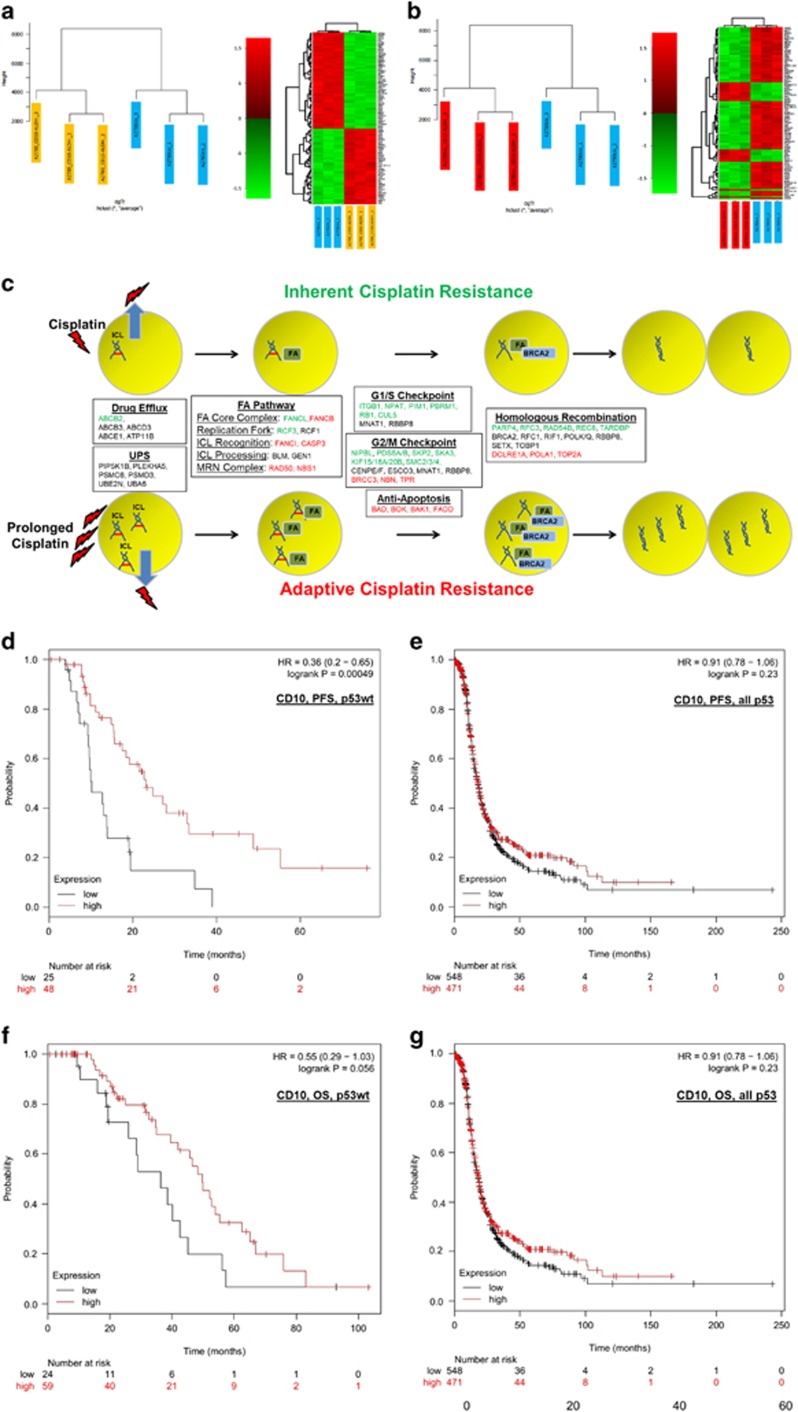
Inherent and adaptive cisplatin resistance in CD10−/ALDH− CSCs is associated with enhanced MDR and DDR mechanisms. The molecular mechanisms associated with CD10−/ALDH− CSC inherent and adaptive cisplatin resistance were identified using whole-genome gene expression array analysis. (a and b) Biological replicates of each cell type were found to cluster well. The full genelists and molecular relationships identified by the online tool ‘DAVID’ are shown in Supplementary Data 4. Selected molecular relationships for inherent and adaptive cisplatin resistance are detailed in Table 1. The majority of these genes relate to specific, inherent- and adaptive-resistance MDR and DDR mechanisms. As illustrated ((c): inherent genes in green, adaptive genes in red, common genes in black font), these relate to drug efflux (MDR), UPS, the FA pathway (DDR), cell cycle checkpoints, antiapoptosis, and homologous recombination. These data indicate a mechanism where cisplatin resistance of CD10−/ALDH− CSCs is facilitated by an enhanced ability to efflux and repair cisplatin-induced ICLs, which is further enhanced by prolonged drug exposure(d–k). To assess its clinical relevance, CD10/ALDH expression was assessed using the online resource tool Kaplan–Meier Plotter (kmplot.com), which facilitates filtered analysis across a large number of published studies. In each case, the numbers of patients within the cohort who had high or low expression of the protein is shown in red and black, respectively. Statistical significance is indicated as logrank P (cutoff P<0.05) as well as relative risk of progressive disease (PFS curves) or death (OS curves) as hazard ratio (HR: cutoff <0.77 or >1.3). For each set of analyses, data are shown for p53wt samples only (‘p53wt’) or all p53 types (‘all p53’). This analysis indicated that CD10 negativity was a predictor of poor PFS (d–e, P=0.00049, HR=0.36), with a trend towards worse OS (f–g, P=0.056, HR=0.55), but only in cases of serous carcinoma patients with p53wt disease. Low expression of ALDH1A3 was also found to be a predictor of reduced PFS (h, P=0.021, HR=0.51) but not OS in p53 wildtype (j, P=0.062, HR=1.8) or in either PFS (i, P=0.0092, HR=1.22) or OS (j, P=0.0033, HR=1.23) when all p53 types were considered together. As a further validation, CD10 expression was assessed in a TMA (Supplementary Data 8) containing germinal centres of (l) tonsil positive control and (m) ovarian cancer patient tumour samples prepared by our group. CD10 expression was negative in the epithelium of all tumour samples (m). In conclusion, CD10/ALDH negativity/low expression may have some utility as prognostic indicators but further validation is required